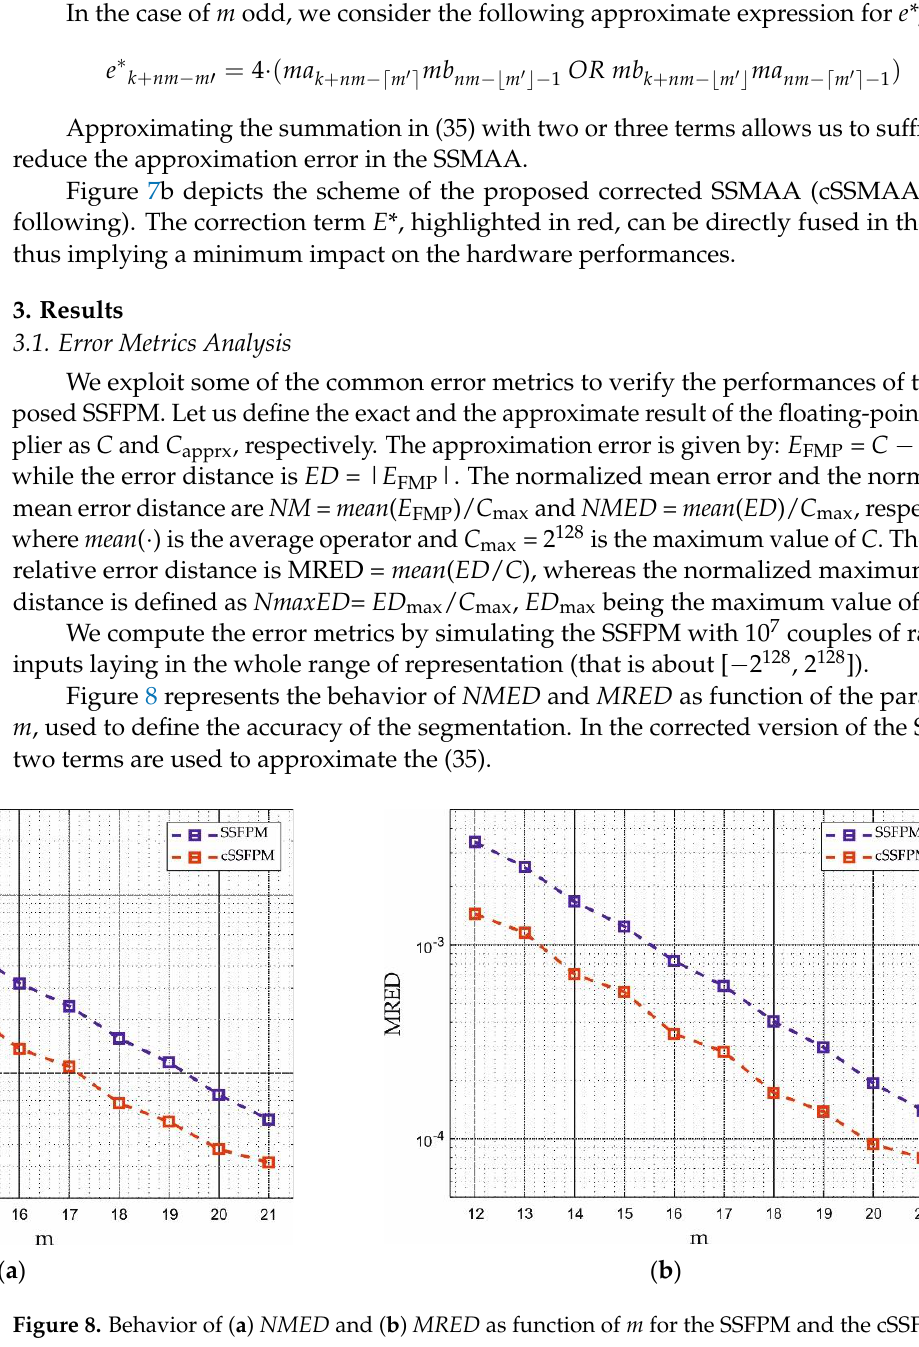
Table 2. Error metrics of the approximate